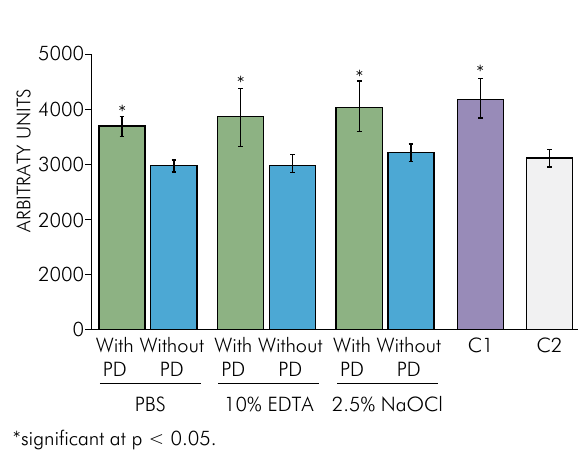
Figure 3. SHED migration through 8-mm-pore membranes toward the media conditioned by tooth slices either containing or not containing the predentin layer (PD) and treated with PBS, 10% EDTA or 2.5% NaOCl, or toward alpha-MEM supplemented with 20% FBS (Control 1 - C 1) or 10% FBS (Control 2 - C 2).